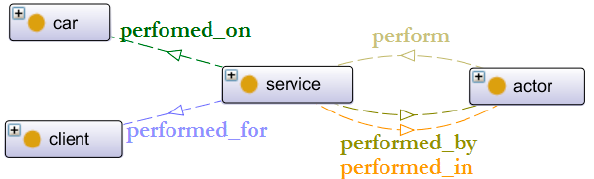
Figure 13. Objects properties of the service.